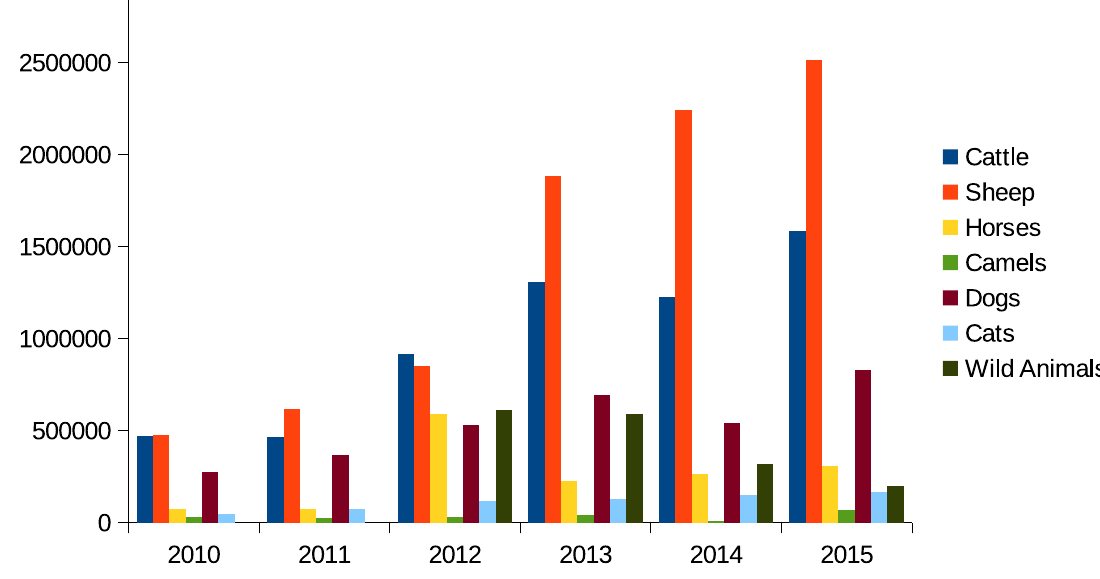
Fig 5. Numbers of animals vaccinated against rabies by species between from 2010 to